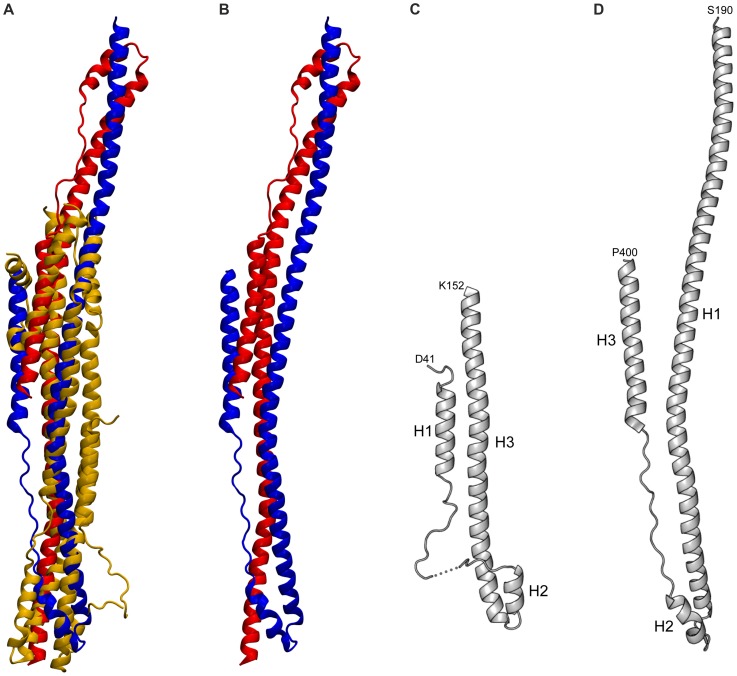
Structural comparison of the rhIE1 with TRIM25.(A) Overlay of dimeric TRIM25 (in blue and red) with monomeric rhIE1 (gold). (B) Dimeric TRIM25. (C) Topological arrangement of helices H1 to H3 of rhIE1. (D) Structure of the TRIM25 monomer.